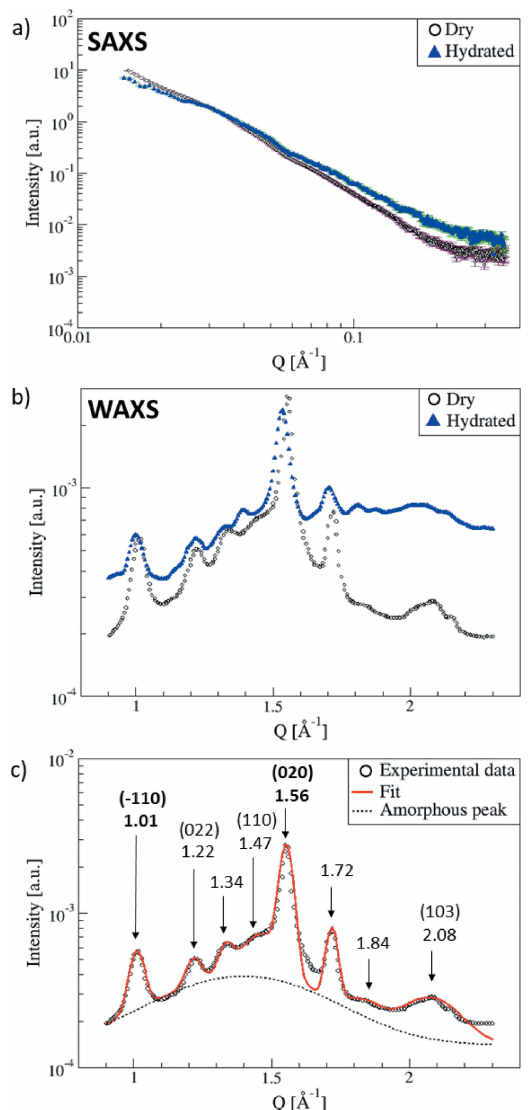
Figure 3 ( a ) SAXS and ( b ) WAXS spectra obtained for the dry and hydrated cellulose membranes measured with a standard holder (dry) and in the pressure cell (hydrated). Errors bars for the WAXS measurements are smaller than the symbols. ( c ) The reflection peaks of the dry sample were fitted with Gaussian functions and an amorphous peak was also added as a background contribution. The ( hkl ) values of the two peaks further analyzed are shown in